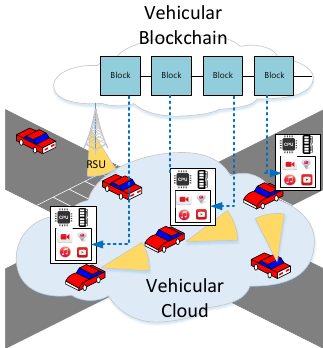
Figure 1. Vehicular cloud and